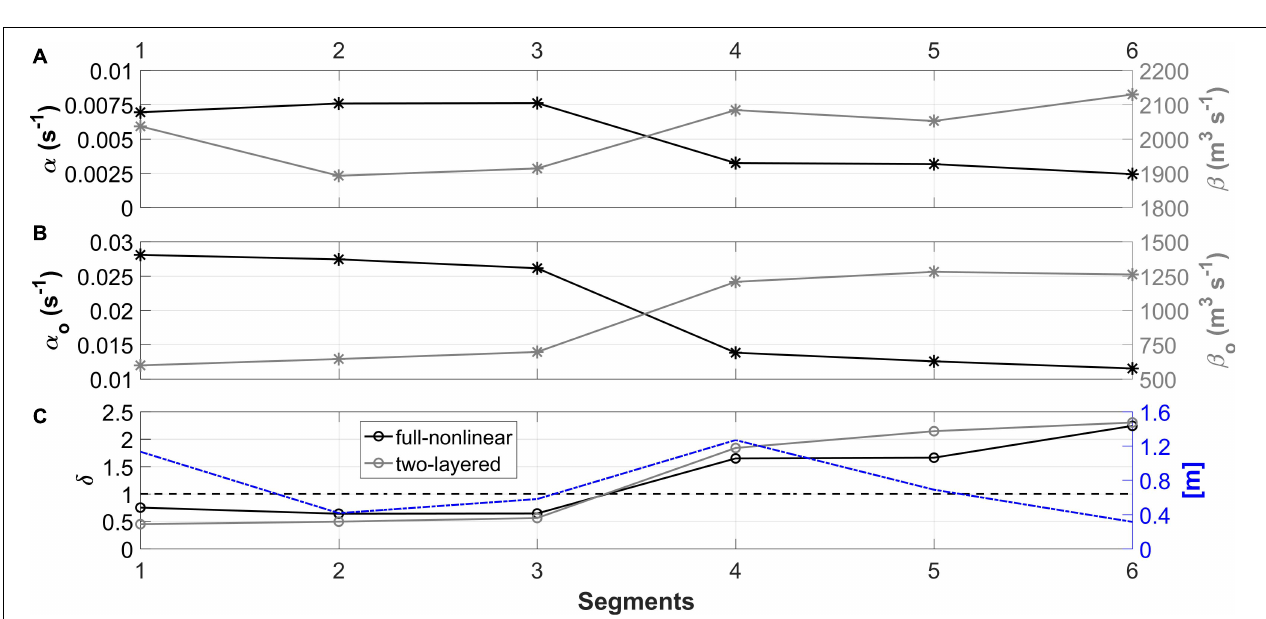
FIGURE 3 | (A) Profiles of Brunt-Väisälä frequency N (rad s − 1 , black) and background current U (m s − 1 , gray) averaged for each relevant 2-day segment (S1 to S6); the hatched vertical segments of each profile signalizes the limits not covered by the deployed arrays of sensors, and the gray vertical dashed line marks the zero m s − 1 . (B) The vertical structure function (cid:56) (z) and phase velocity values for the first baroclinic mode determined through the full-nonlinear Dubreil-Jacotin-Long method (respectively, DJL and c j ) and without background currents (DYN and c d ).